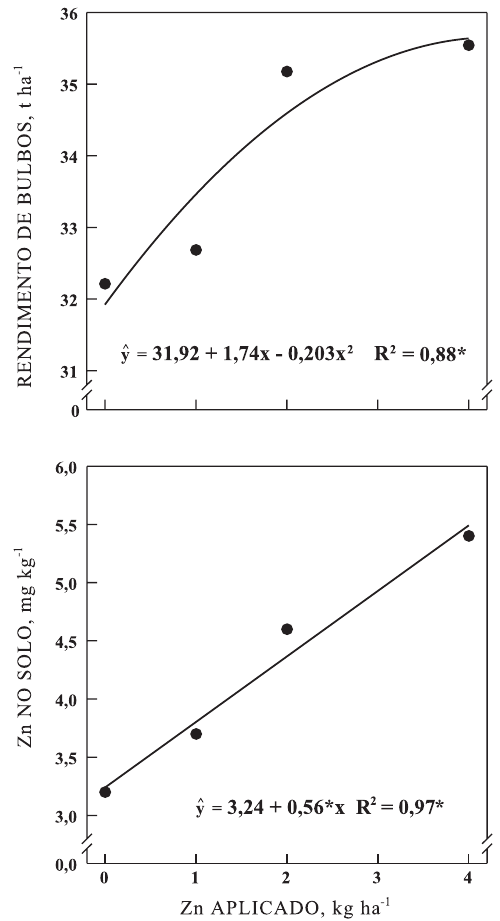
Figura 3. Produtividade de bulbos de cebola e teor de Zn no solo na safra 2008/2009, em função da adição de doses crescentes de Zn ao solo antes do plantio. Média de quatro repetições. * Significativo (p < 5